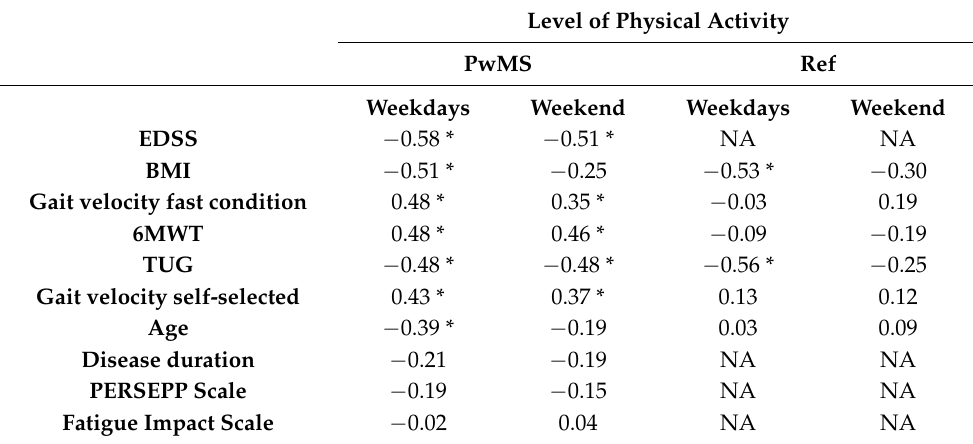
Table 4. Correlations among the level of physical activity (counts · min − 1 ) and clinical and functional parameters for PwMS and Ref groups.